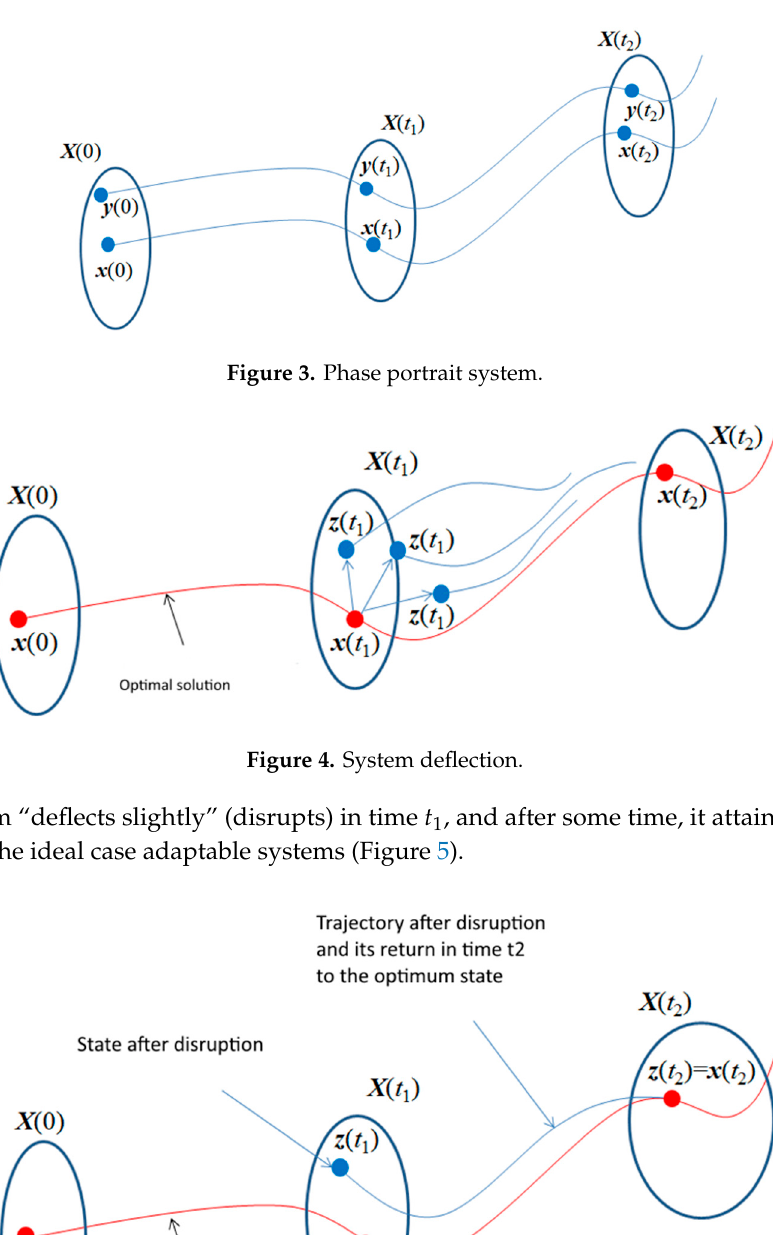
Figure 5. Adaptable systems.